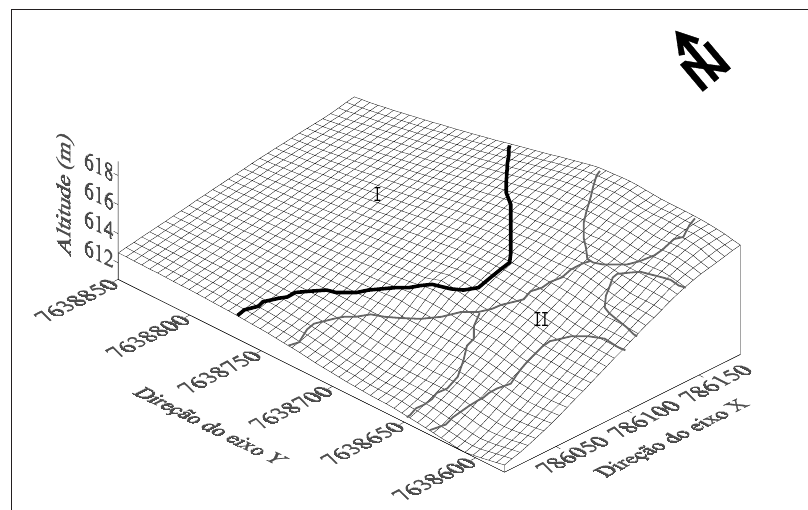
Figura 1. Modelo de elevação digital da área de estudo, com compartimentos identificados (I e